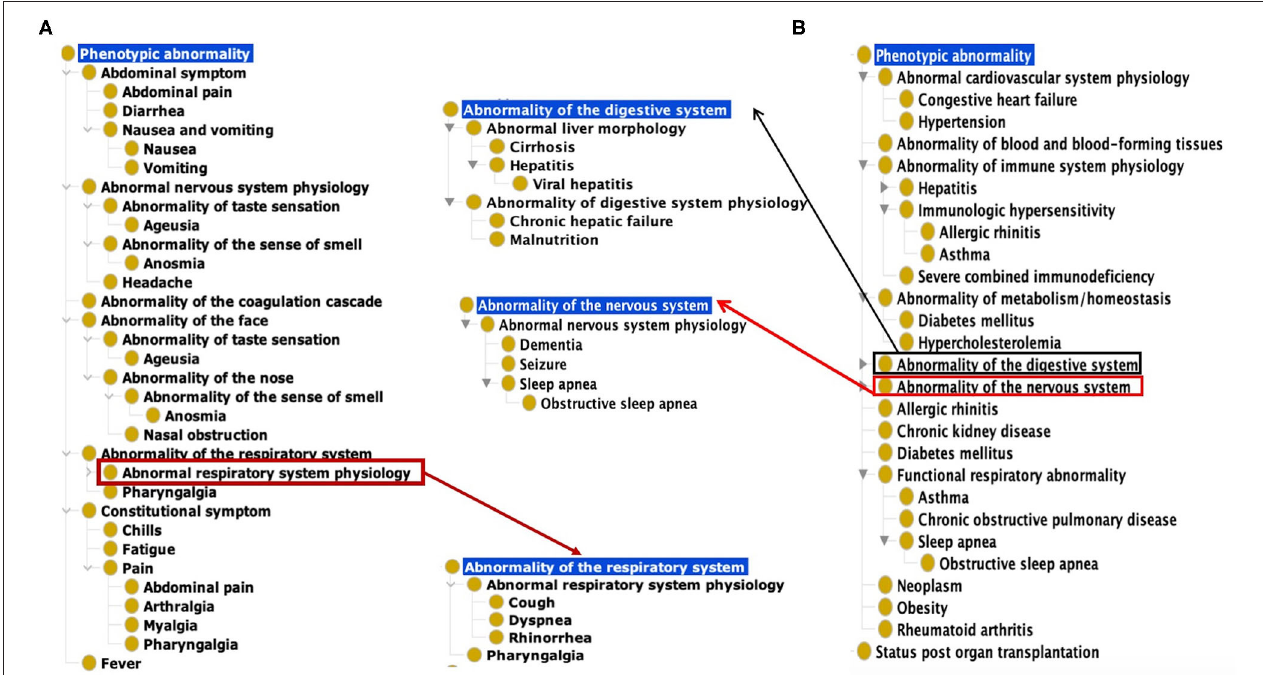
FIGURE 1 | Common COVID-19 symptoms and comorbidities represented using the Human Phenotype Ontology (HPO). (A) 18 Common symptom phenotypes of COVID-19 based on HPO classification. The list of these 18 phenotypes is provided in Supplementary Table 1 . (B) Hierarchical lay of 22 common comorbidity phenotypes based on HPO classification. The list of these 22 phenotypes is also provided in Supplementary Table 1 .